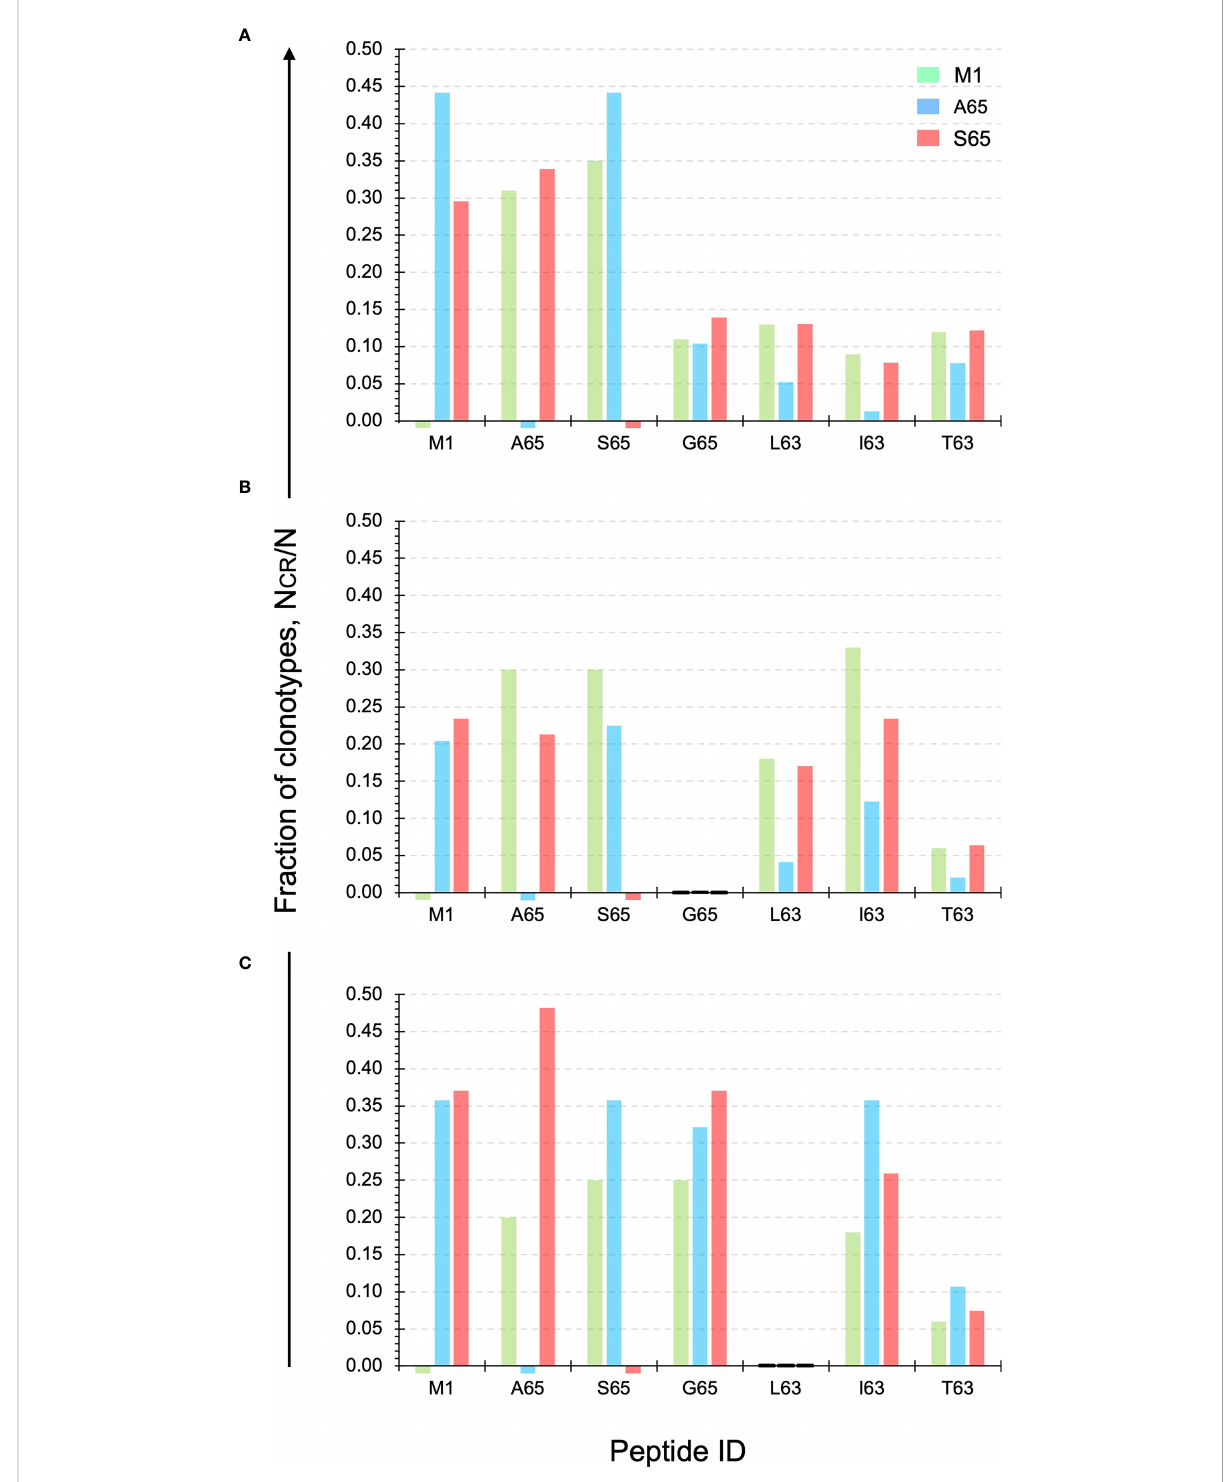
FIGURE 4 Cross-reactivity of the M1, A65, and S65 repertoires. Each panel ID, (A – C) corresponds to the donor ID. The y-axis shows the fraction of clonotypes from the two candidate and M1 repertoires that are also present in the repertoires identi fi ed on the x-axis. The M1 and candidate repertoires are identi fi ed by color. The relative fraction for the M1 and candidate repertoires compared against themselves, which is “ 1 ” , is omitted for clarity. Data is provided in Supplemental Table